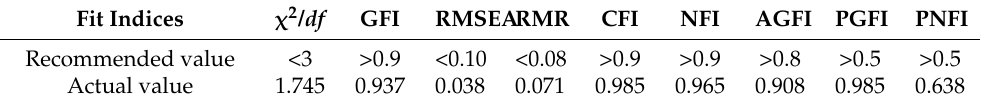
Table 2. Fitting index of